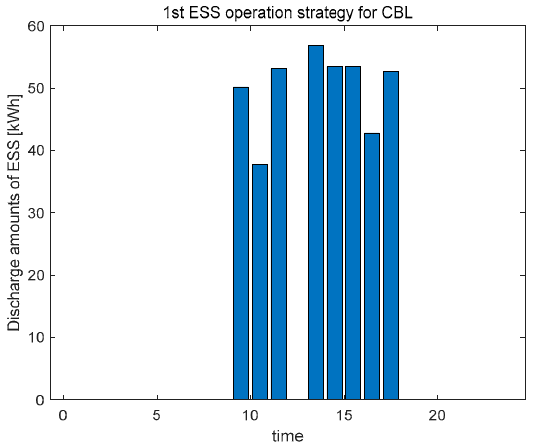
Figure 2. Energy Storage Systems (ESS) scheduling with Gaussian Mixture Model (GMM).